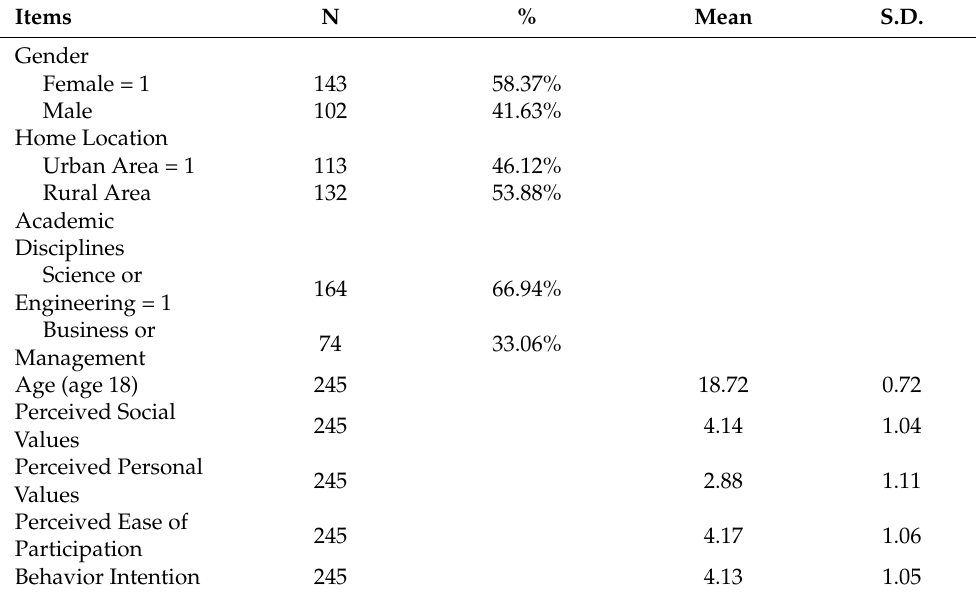
Table 2. Descriptive statistics for the